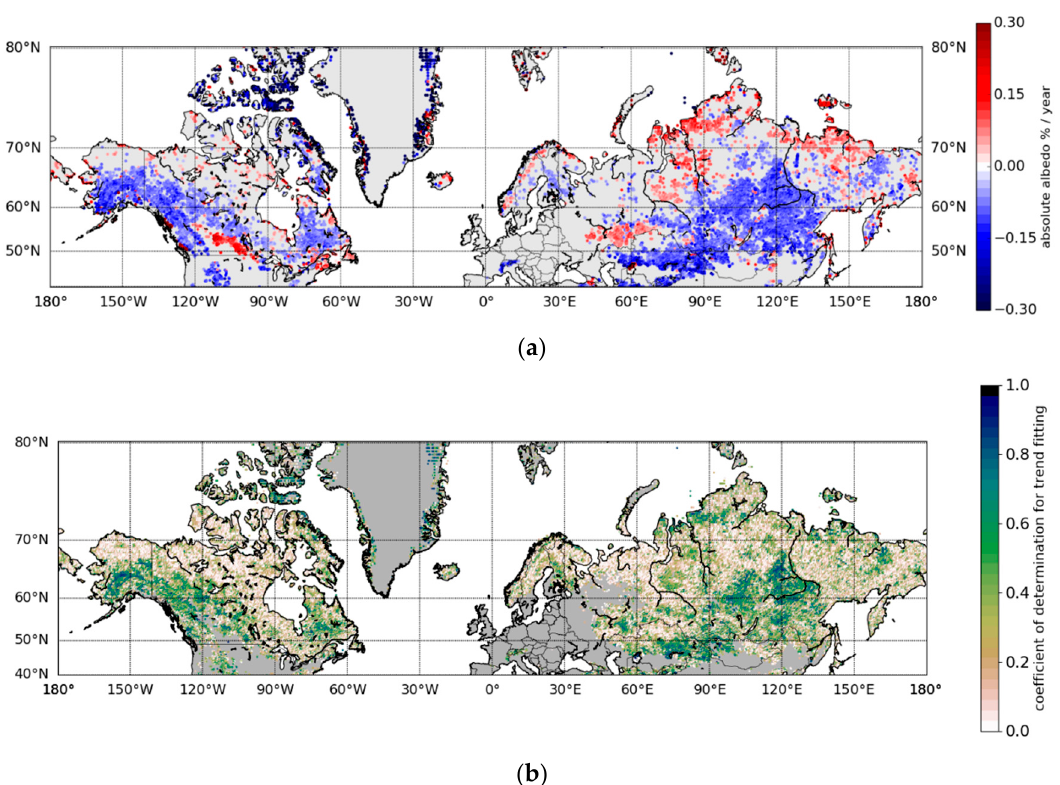
Figure 5. The areas listed in Table 2.